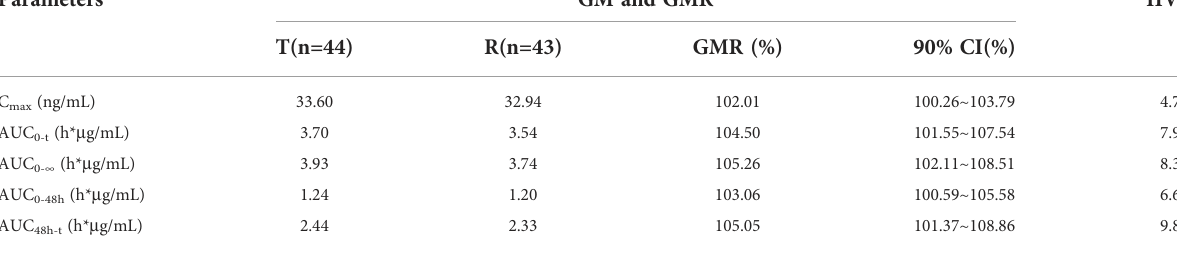
TABLE 6 The Bioequivalence Analysis of Liposome Encapsulated Doxorubicin.